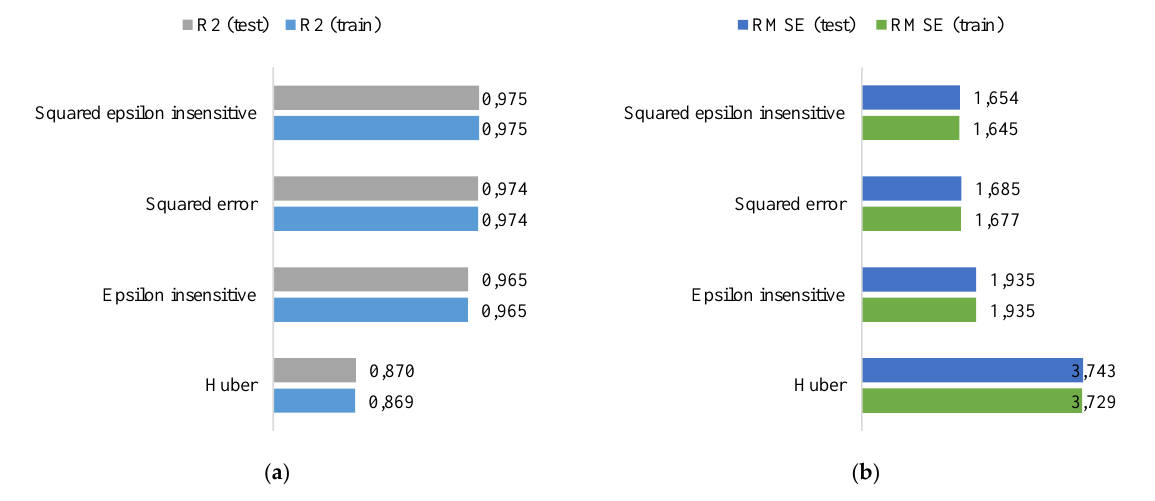
Figure 4. Accuracy of the SGD algorithm using different loss functions: ( a ) R2; ( b ) RMSE.